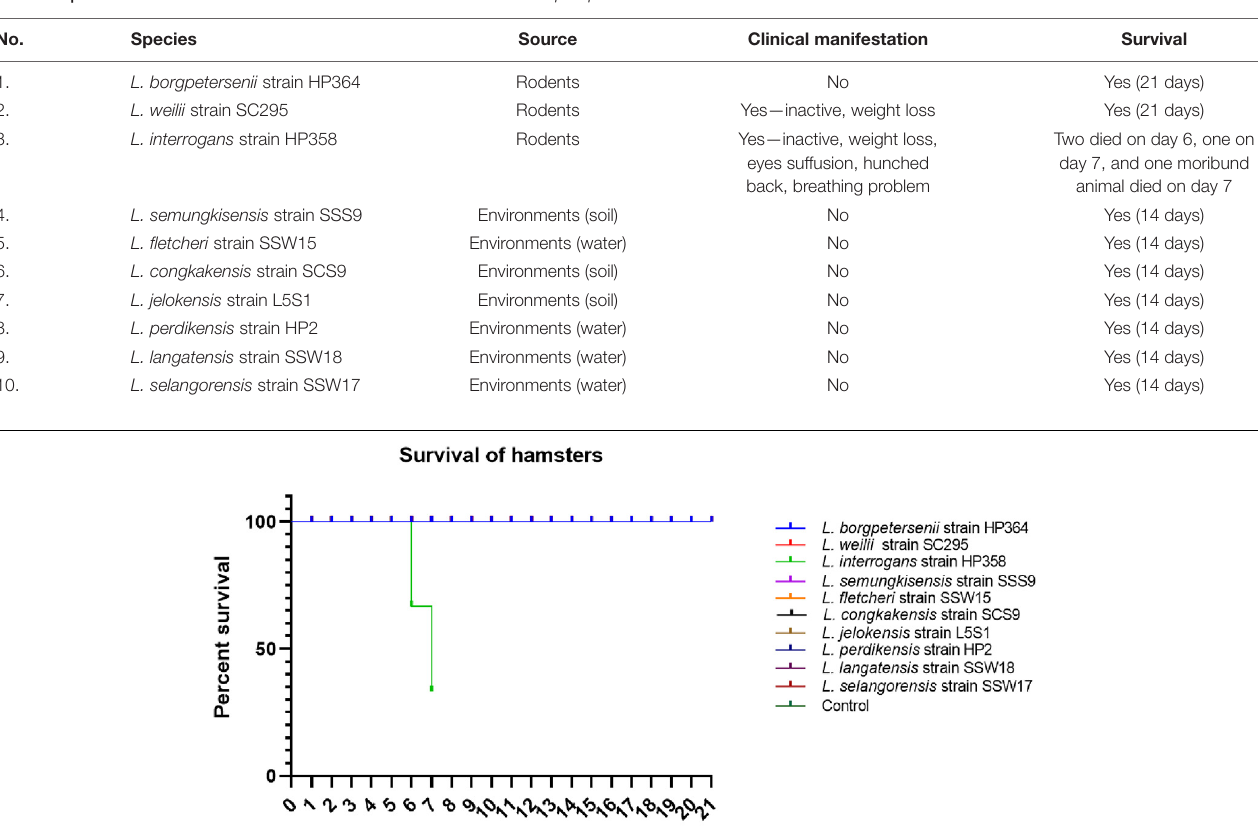
virulence factors, Loa22, FliN, ClpB, HtpG, LipL32, hemolysin B, and hemolysin C were found to be common among the pathogenic Leptospira species and strains with ≥ 90% identity